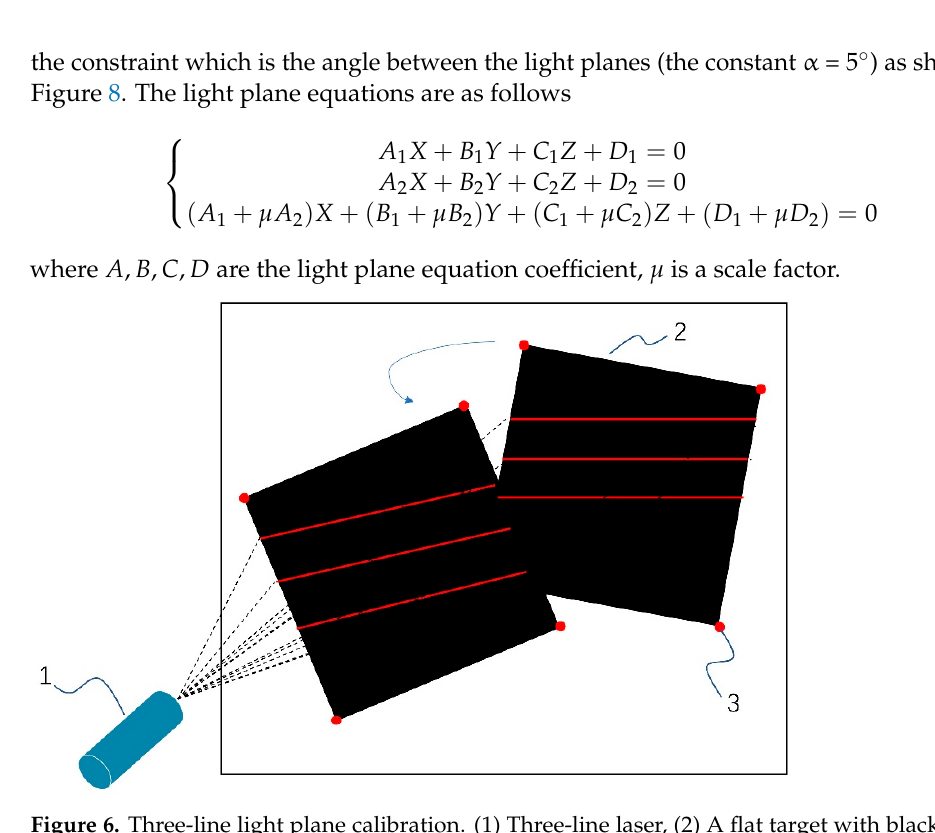
Figure 7. Three sets of 3-D points.